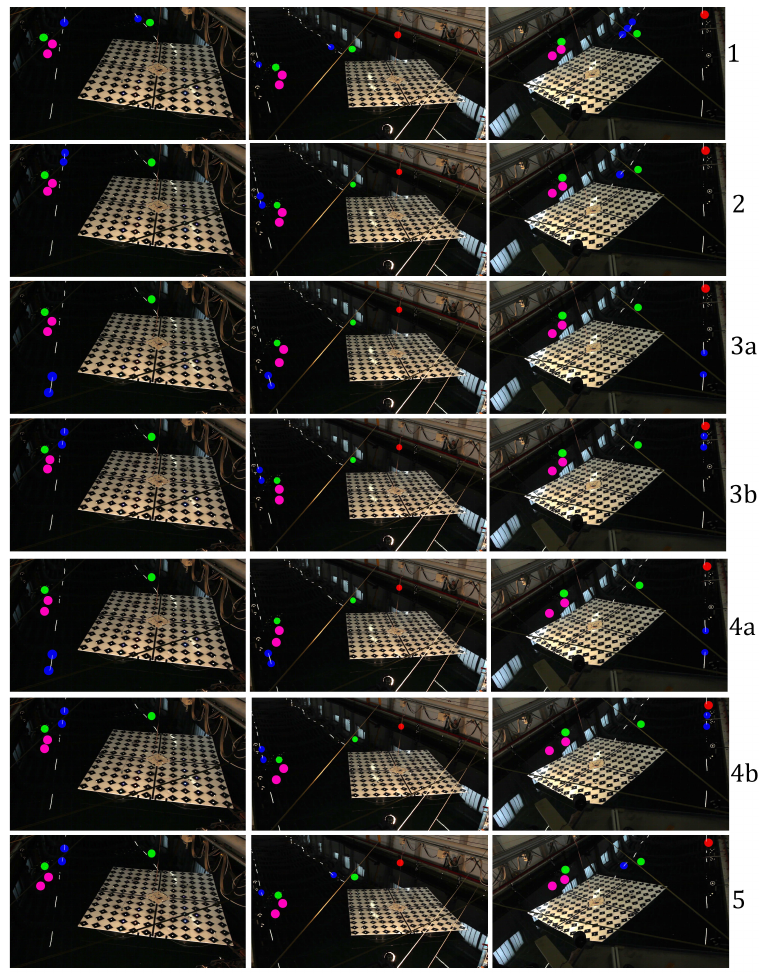
Figure 12. Distribution of observed highlights (blue) used in m2 , artificial targets used in m1 (magenta), validating targets (green) and the capacitive level sensor (red) in three camera views, in all measurement series.